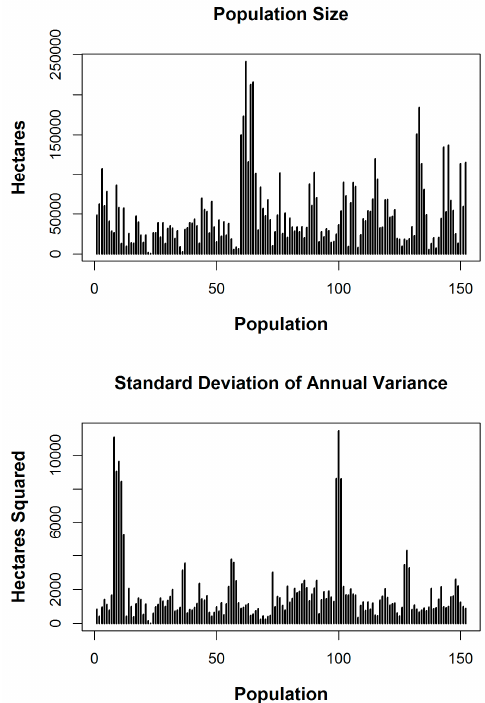
Figure 1. The size in hectares for the 152 Step 2 populations ( top ), and the standard deviation of the within population annual variance ( bottom ), prior to expansion of each population in Step 3 using the Pólya urn approach.